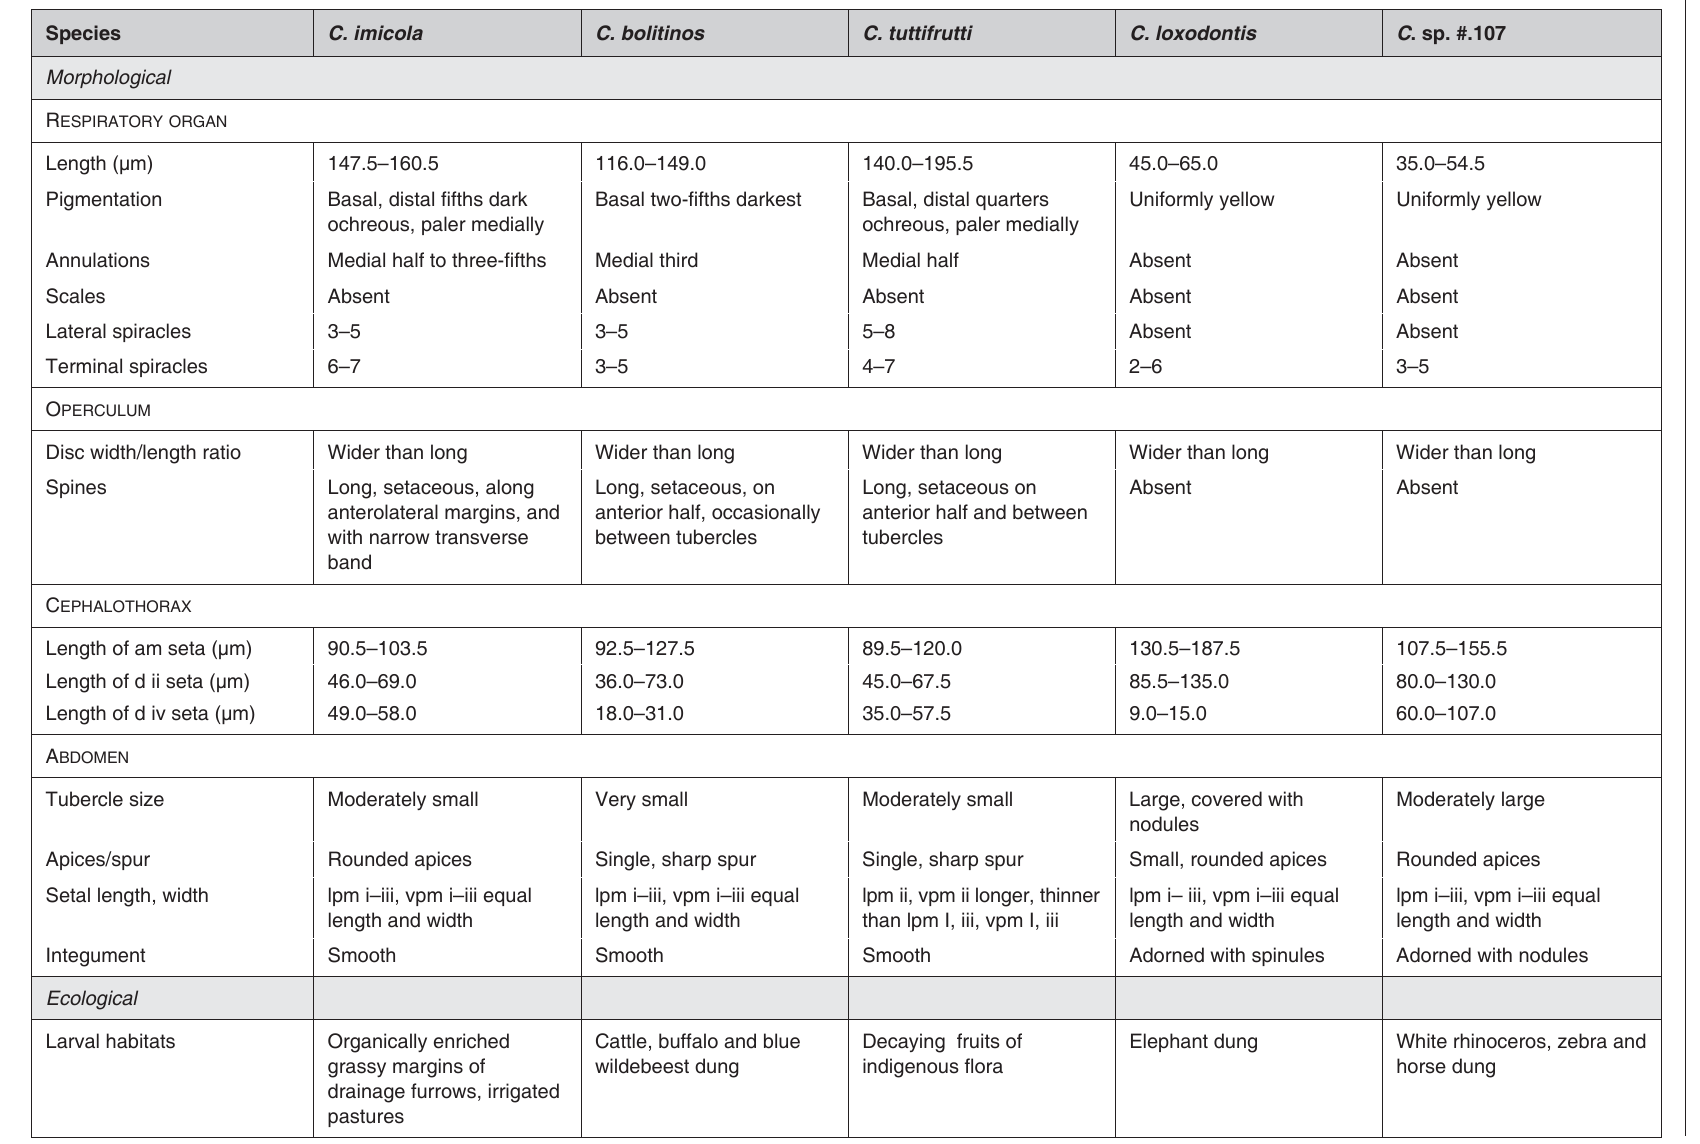
TABLE 6 Morphological and ecological similarities and differences amongst five species of Culicoides of the Imicola